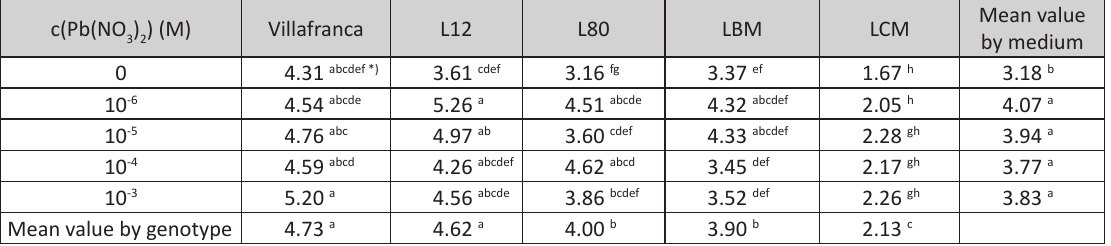
Number of roots in white poplar on examined lead concentration in medium (LSD test)